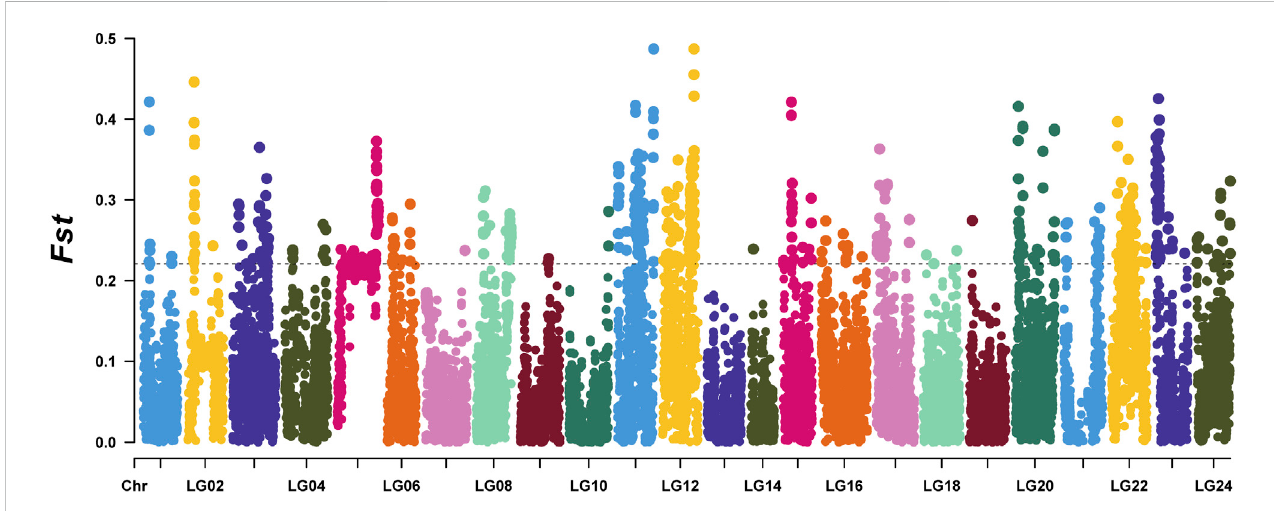
FIGURE 2 The distribution of Fst values between the mandarin fi sh which could be domesticated to accept arti fi cial diets and those could not.